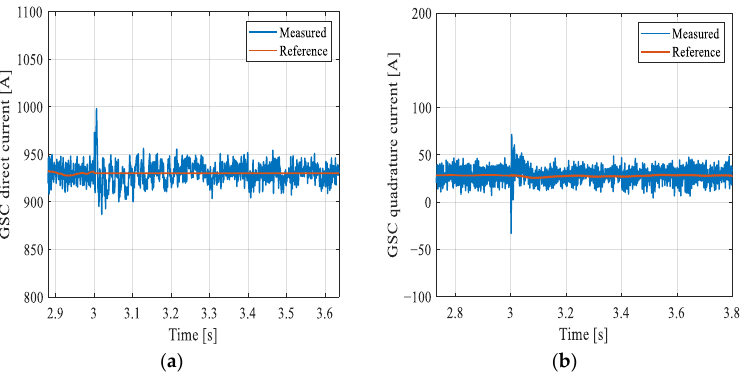
Figure 19. GSC currents during an unbalanced voltage sag of 70%: ( a ) d axis component and ( b ) q axis component.